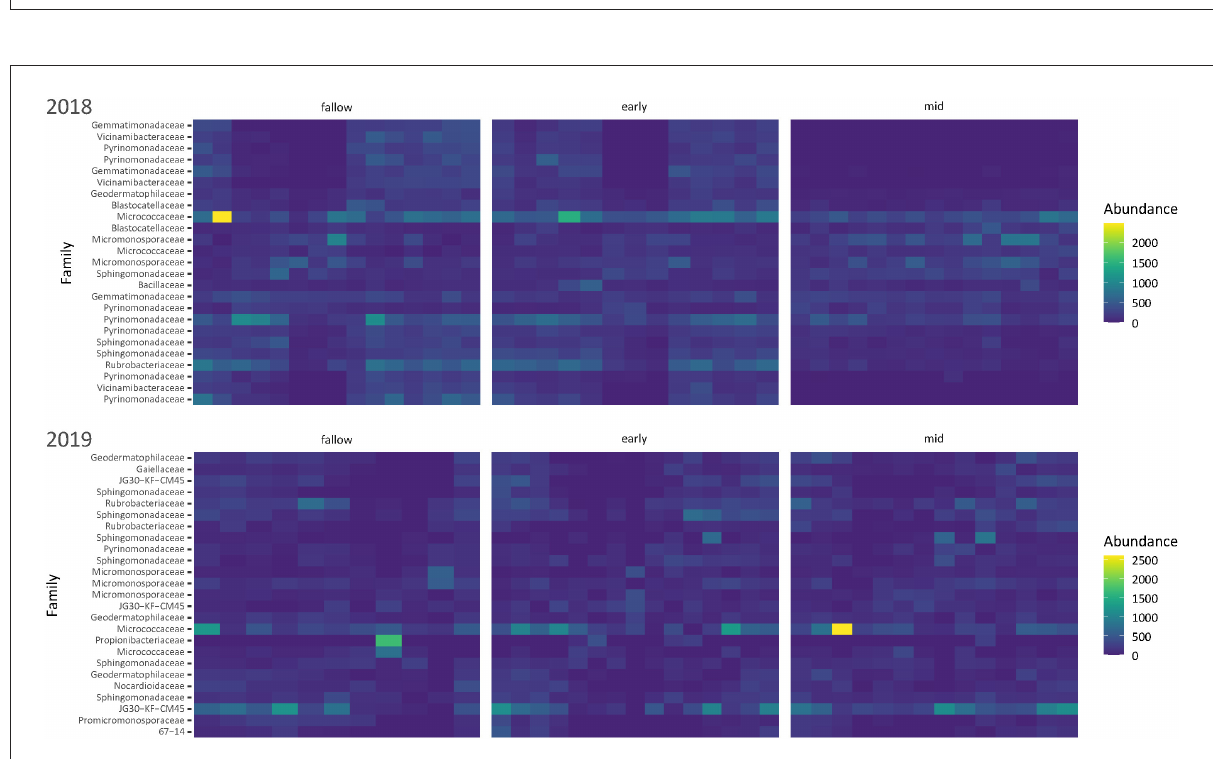
FIGURE6 Heatmap of the most abundant sequence variants identified at the family level for each year. Taxa not present or at very low abundance in samples were set to display as the closest limit (0) for visual